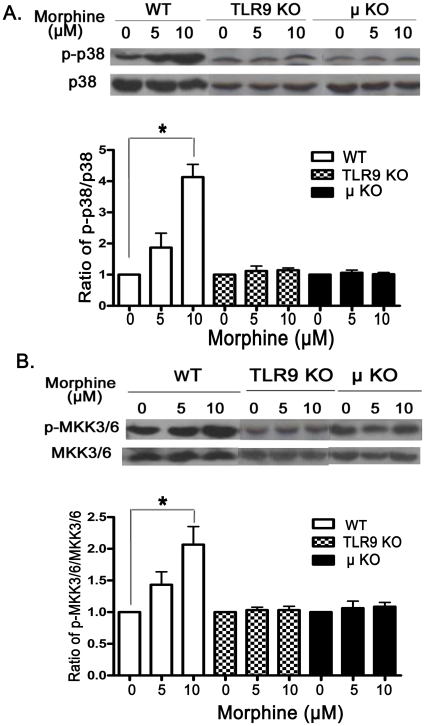
Effect of morphine on p38 MAPK and MEKK3/6 activation.WT, TLR9 KO, and µOR KO microglial cells were treated with morphine
at 5 and 10 µM for 24 hr. (A) Total and phosphorylated p38 MAPK
(p-p38 MAPK) levels were determined by Western blot. Mean values were
derived from three independent experiments. *
p<0.01 compared with indicated groups. (B) Total and
phosphorylated MKK3/6 (p-MKK3/6) levels were examined by Western blot.
Mean values were derived from three independent experiments. *
p<0.01 compared with indicated groups.